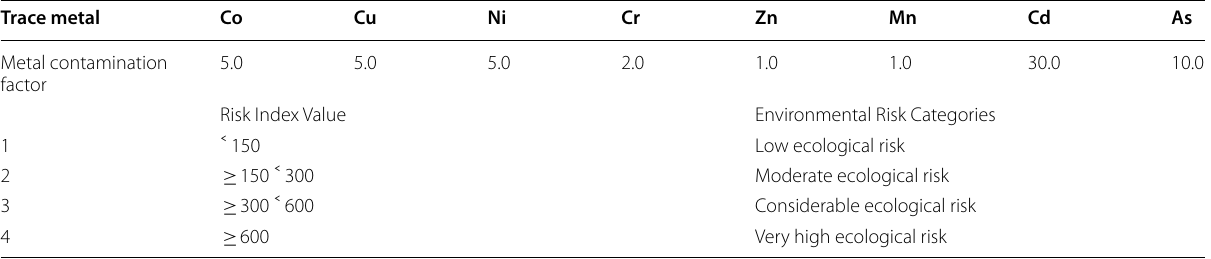
Table 5 Metal contamination factor (Fi) of the selected trace metals, classification and environmental risk intensity Trace